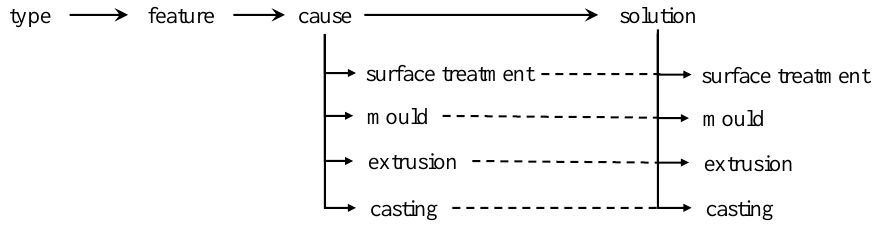
Figure 10. Tracing analysis on formation mechanism of surface defects.